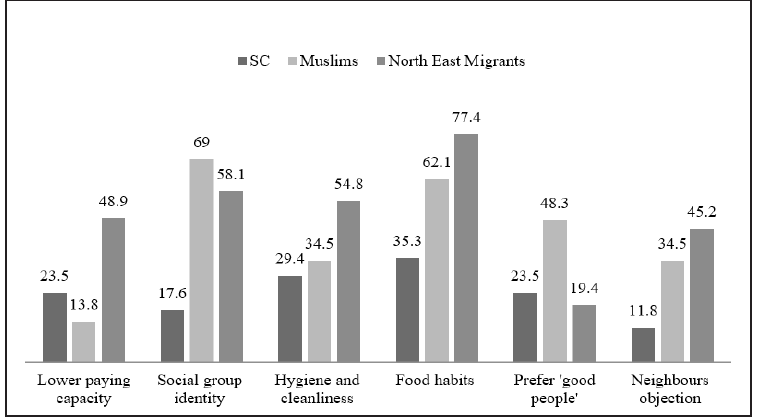
Fig 2. Reasons for Denial of House (Stated by House Owner) Source: Primary Field Survey